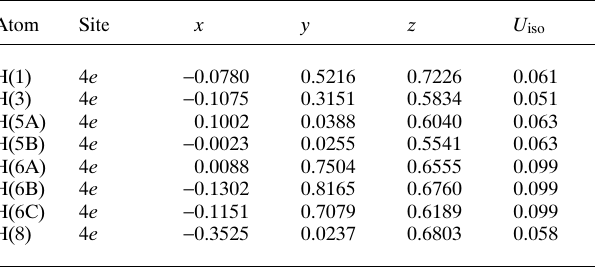
Table 2. Atomic coordinates and displacement parameters (in Å 2 )